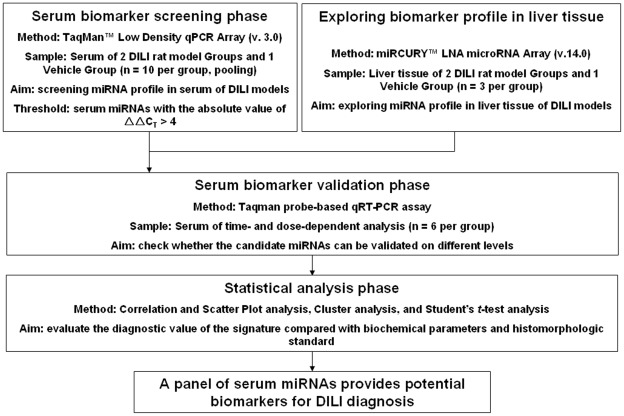
Overview of the experimental strategy.